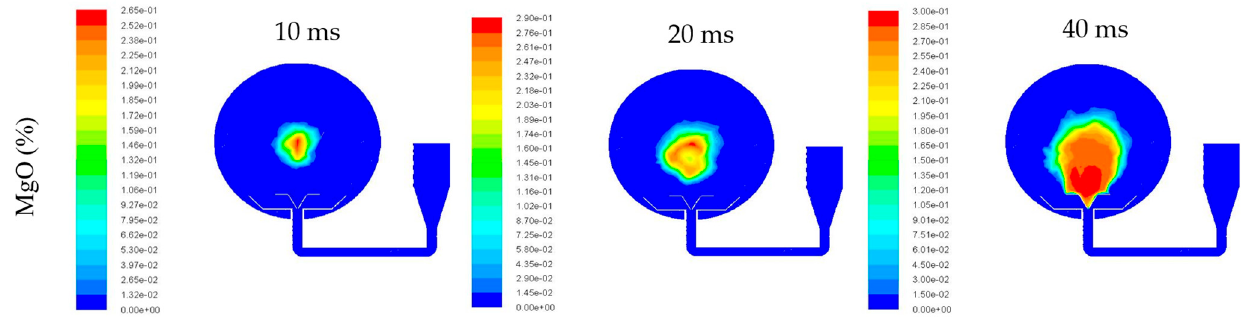
Figure 10. MgO generation after ignition for 250 g/m 3 .